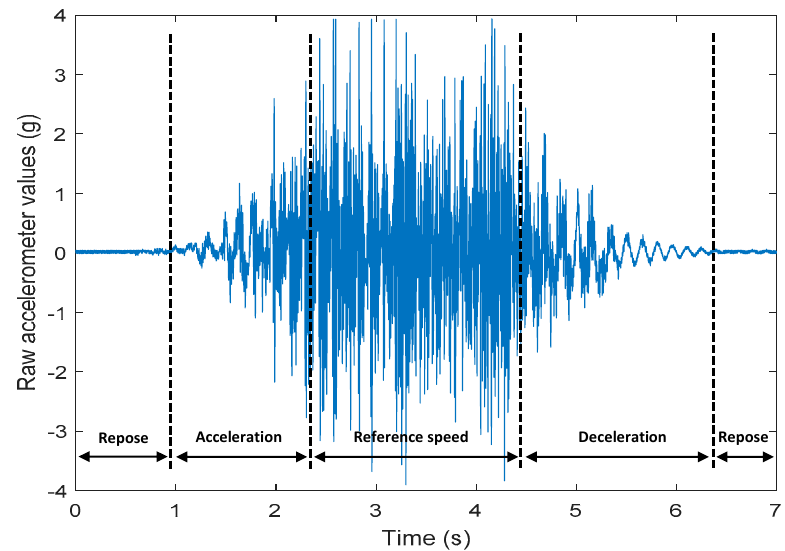
Figure 10. Raw accelerometer data obtained at the head of the APR-1 prototype when the forward speed was fixed at 66 cm/s.